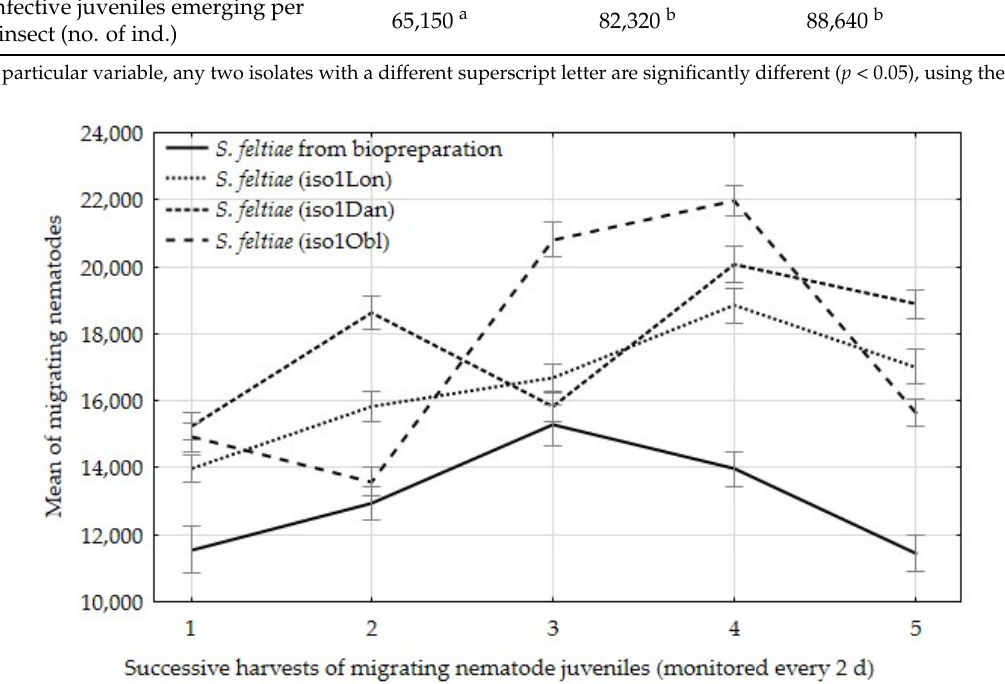
Figure 4. Comparison of mean of migrating nematode juveniles from host insects from the dif- ferent Steinernema feltiae isolates, ±standard deviation (SD).